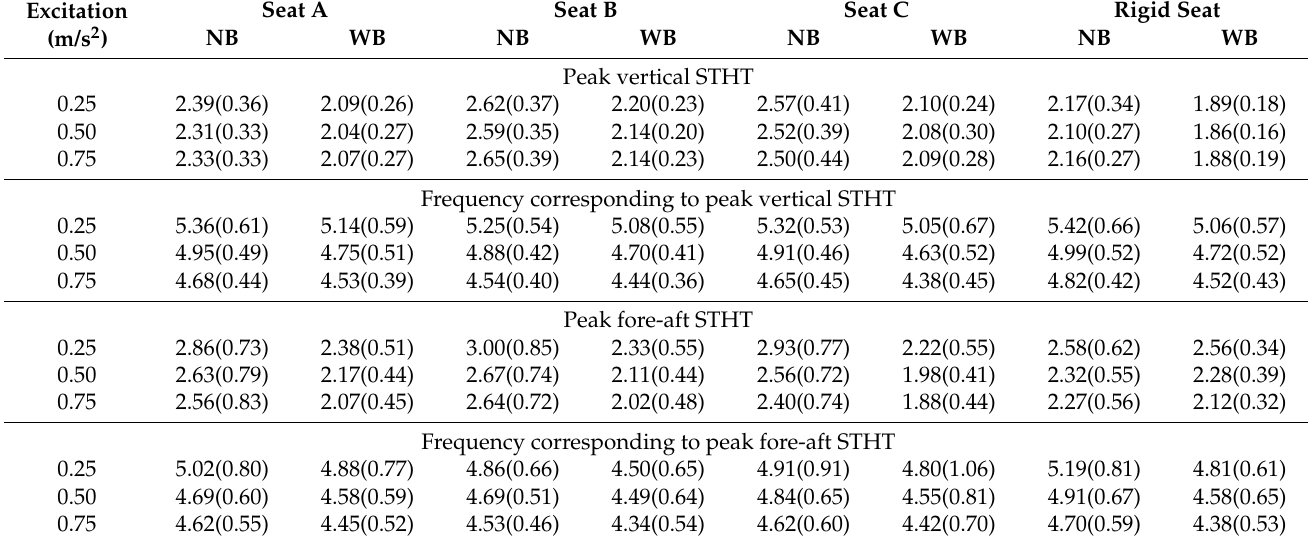
Table 4. Mean (standard deviation) of the peak STHT magnitudes and the corresponding frequencies obtained for the 58 participants with two sitting conditions and three excitation